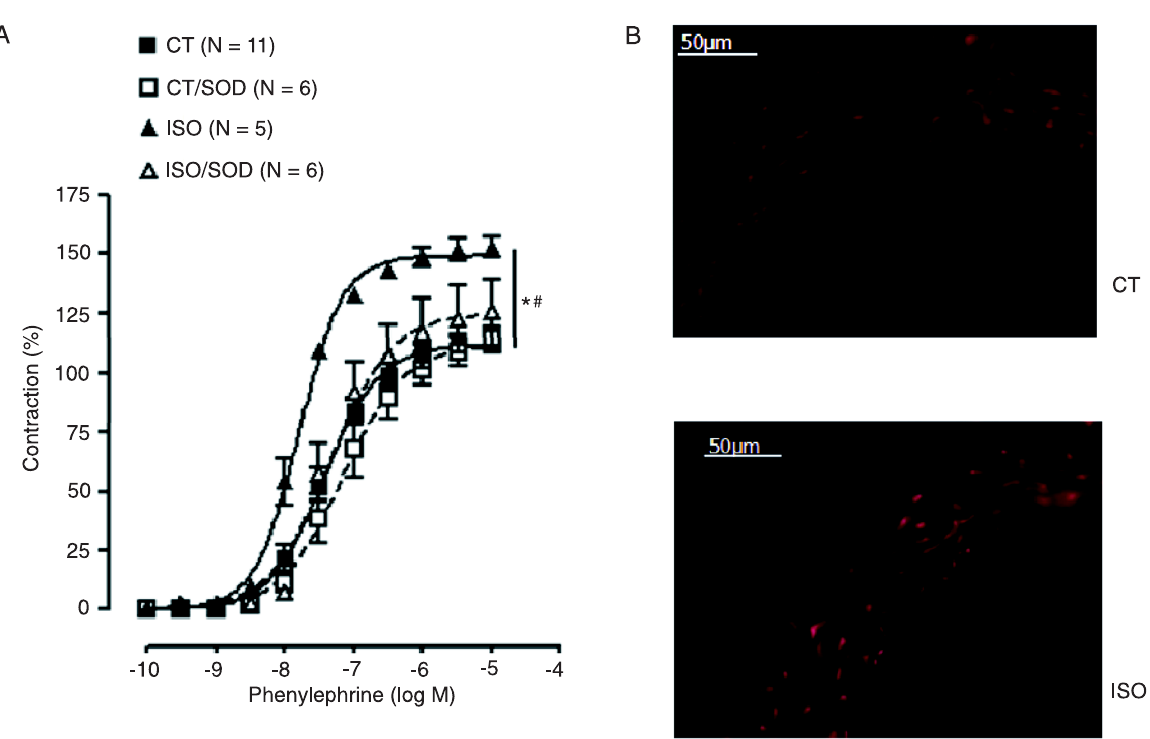
Figure 3. Effect of 7-day isoproterenol treatment on vascular function and superoxide generation in mouse aorta. A , Contraction response to phenylephrine in aortas with endothelium from control (CT) and isoproterenol (ISO)-treated FVB mice. Superoxide dis- mutase (SOD) incubation (150 U/mL; 30 min) restored the contractile response to phenylephrine of isoproterenol-treated rats. Data are reported as a percentage of the response to 75 mM KCl in each aortic ring. Data are reported as means ± SEM. *P < 0.05 ISO vs CT; # P < 0.05 ISO vs ISO/SOD (two-way ANOVA). B , Representative fluorescence photomicrographs of slices of aorta from CT and ISO-treated FVB mice. Vessels were labeled with the oxidative dye hydroethidine, which produces a red fluorescence when oxidized to ethidium bromide by superoxide